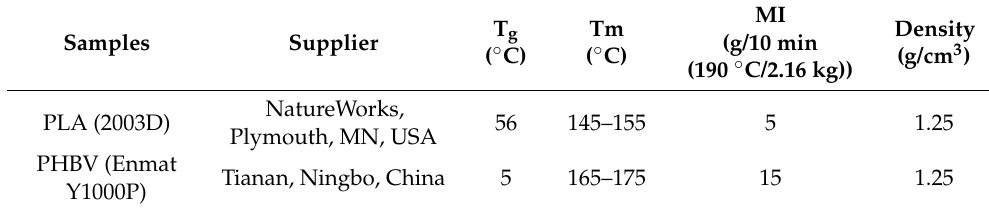
Figure 1. Chemical structure of pure PLA and PHBV. Table 1. Information and properties of PLA and PHBV.